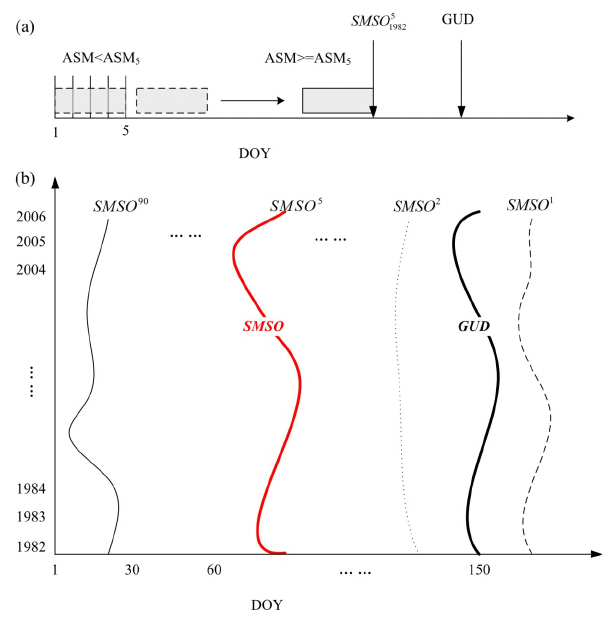
Fig. 3. (a) Schematic chart of the definition of Soil Moisture Spring Onset date (SMSO), a fixed window (e.g., 5-day) moving afterward from the first day of the year (e.g., 1982) until the accumulated soil moisture reaches the threshold ASM 5 , then the last day of the window is SMSO 5 ; (b) The maximizing process to get the optimal length of accumulation period. For each window (e.g., 1 to 90), we get the corresponding time series of SMSO from 1982 to 2006 (i.e., SMSO 1 , ..., SMSO 90 ), after calculating the correlation between each SMSO time series with GUD time series, we could pick out the SMSO time series with the best correlation coefficient, then the corresponding window size is the optimal length of accumulation period (i.e., 5).